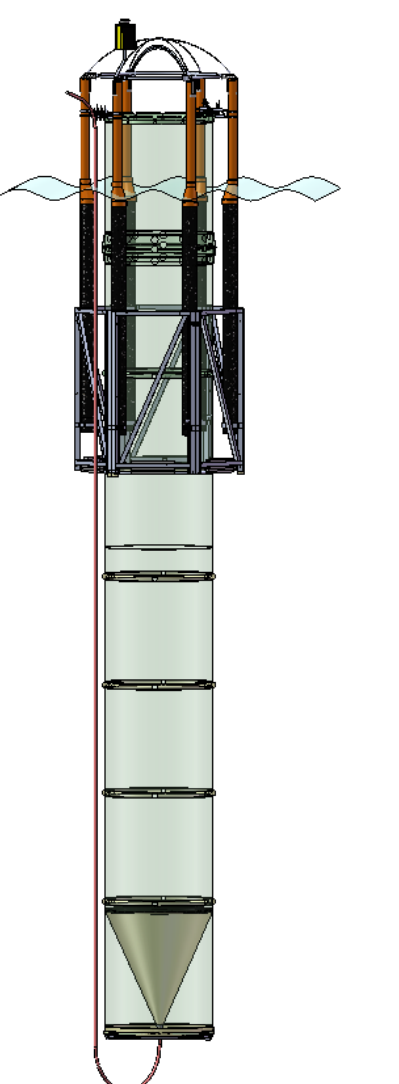
Fig. 2. Schematic drawing of a KOSMOS mesocosm deployed in Kongsfjorden, with its characteristic dead space below the sediment trap, shown in dark grey, at the